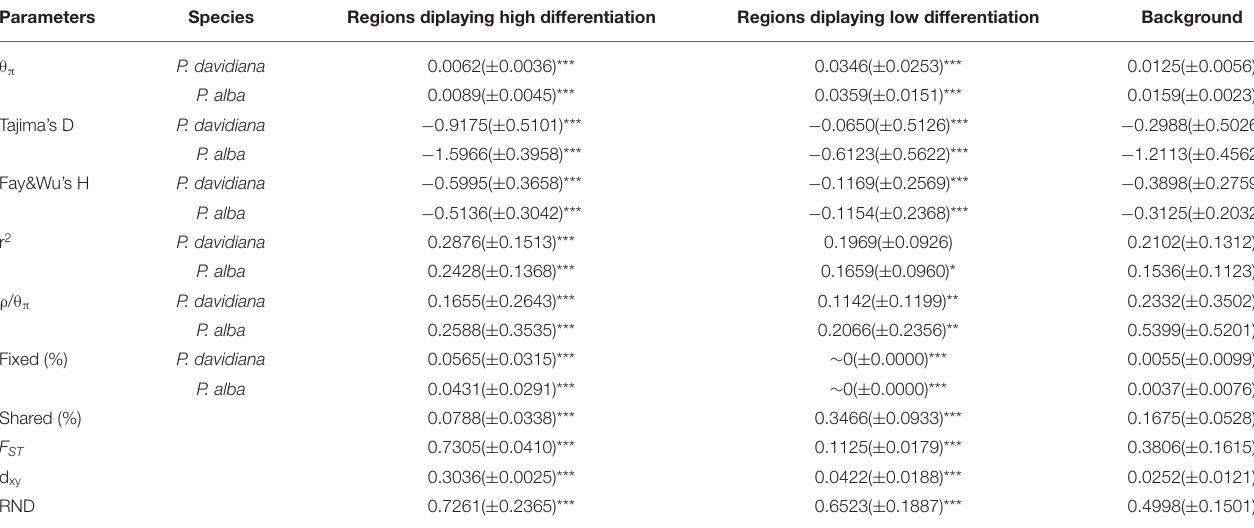
TABLE 4 | Statistics s ummary comparing regions displaying extreme genetic differentiation with the rest of the genomic regions in both P. davidiana and P. alba (the values are shown as mean ± standard deviation).